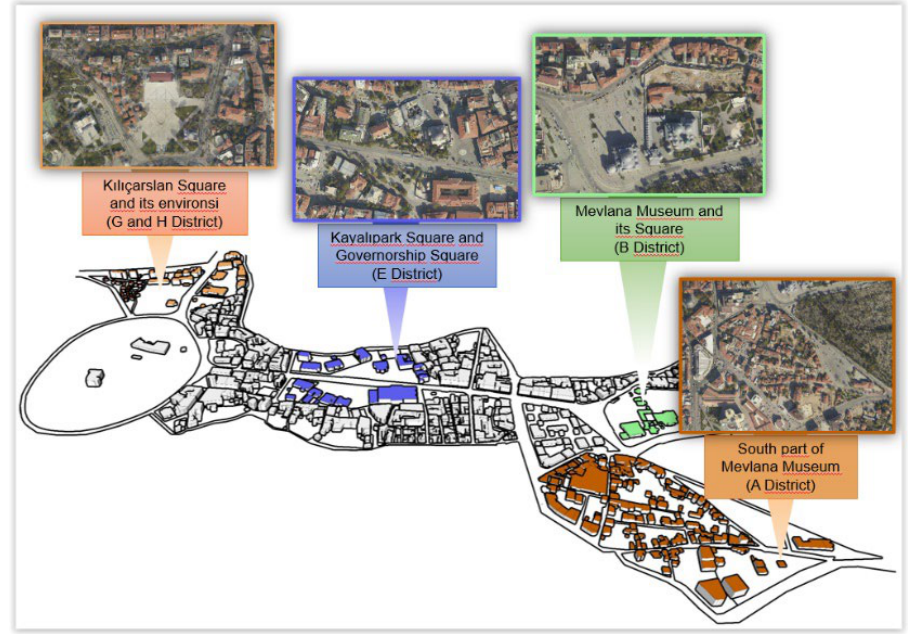
Figure 12 Districts that show imbalanced distribution in solid-void ratios according to the figure-ground analysis (Ünal,